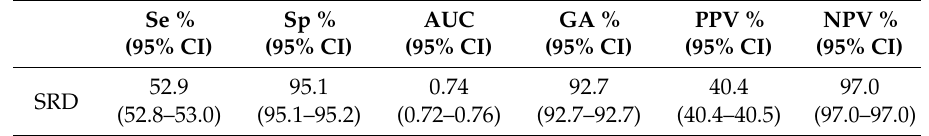
Table 2. Performance of self-reported depression (SRD) in identification of individuals with depression (PHQ-8 ≥ 10) in the general population. European Health Interview Survey in Spain, 2014 / 2015.